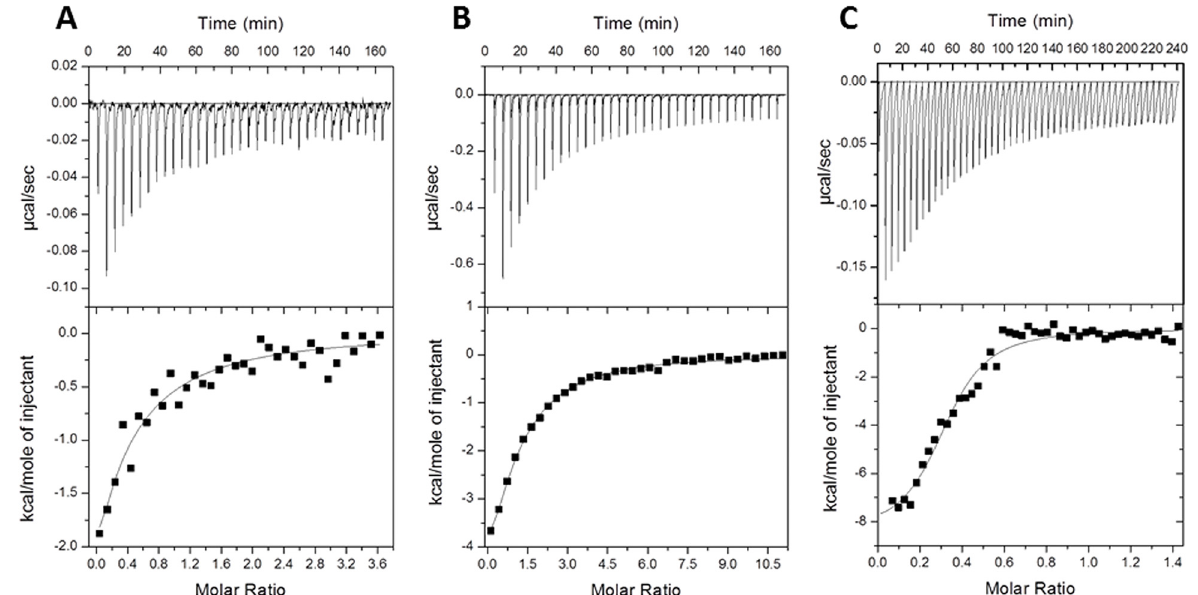
Fig 6. ITC isotherms for the binding of TtgR E78A mutant to: A) chloramphenicol, B) naringenin and C) phloretin. Experiments were performed as described in “ Materials and Methods section ” at 30°C with injections of the effector diluted in dialysis buffer into the protein. Upper panels: Heats changes for injections. Lower panels: Experimental heats measured for each effector injection. The curves correspond to the best fit using “ one type of sites ” model.